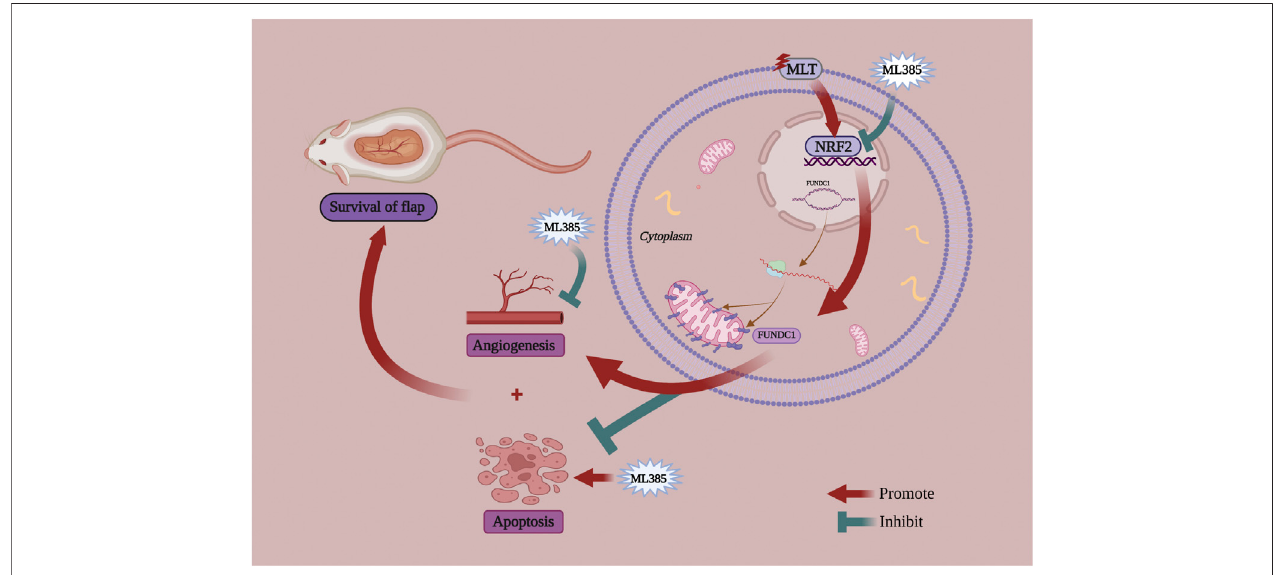
FIGURE 8 | A schematic diagram illustrating MTL improve the survival of multiterritory perforator fl aps by promoting angiogenesis and inhibiting apoptosis via the NRF2/FUNDC1 axis.